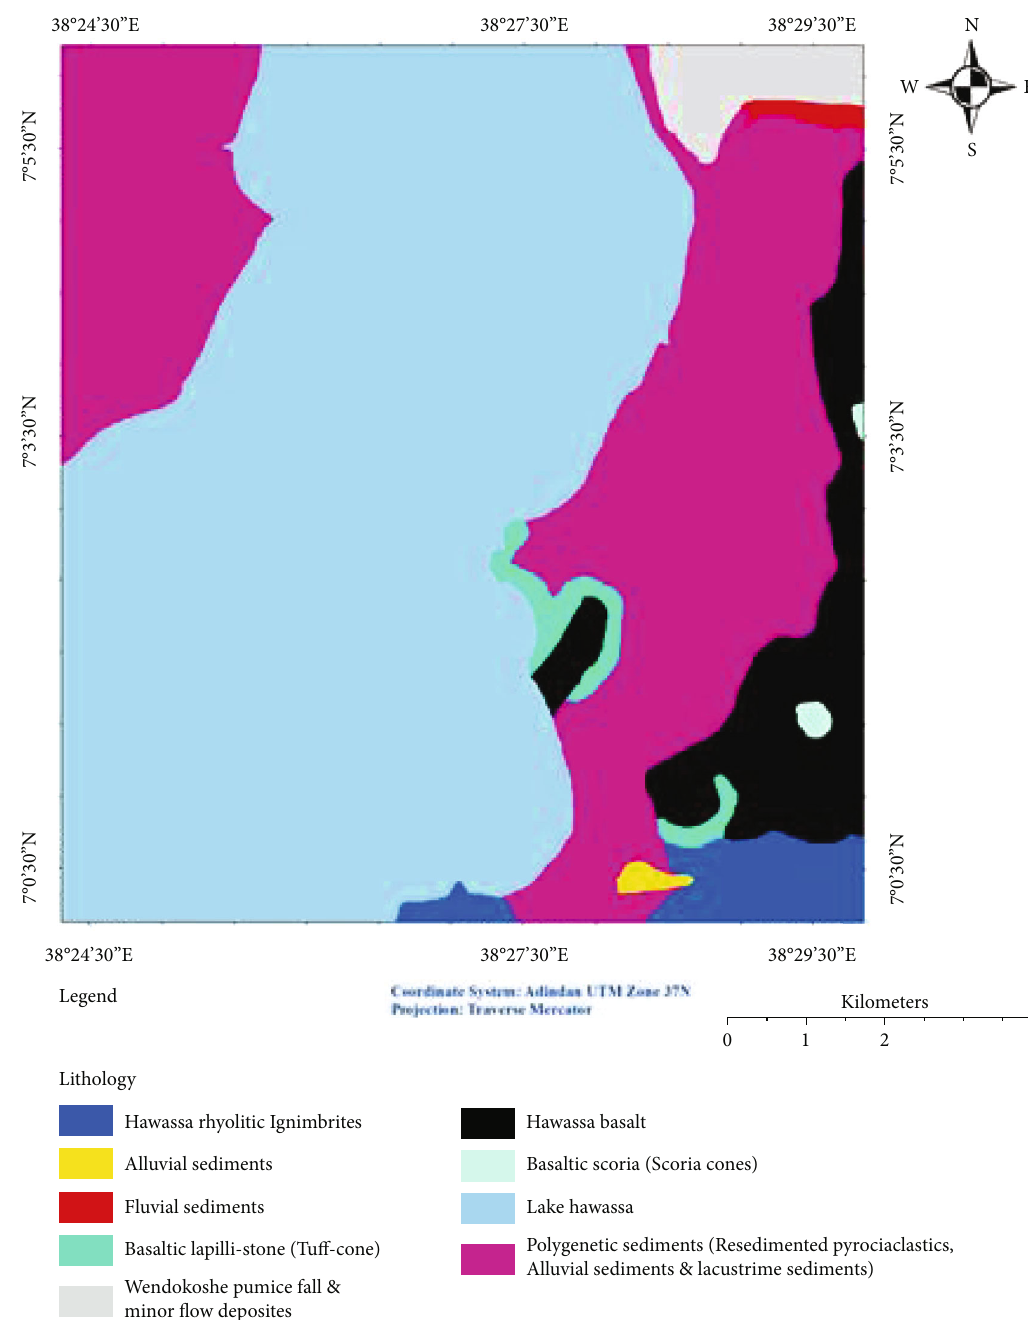
Figure 2: Geological map of Hawassa area (modi fi ed after